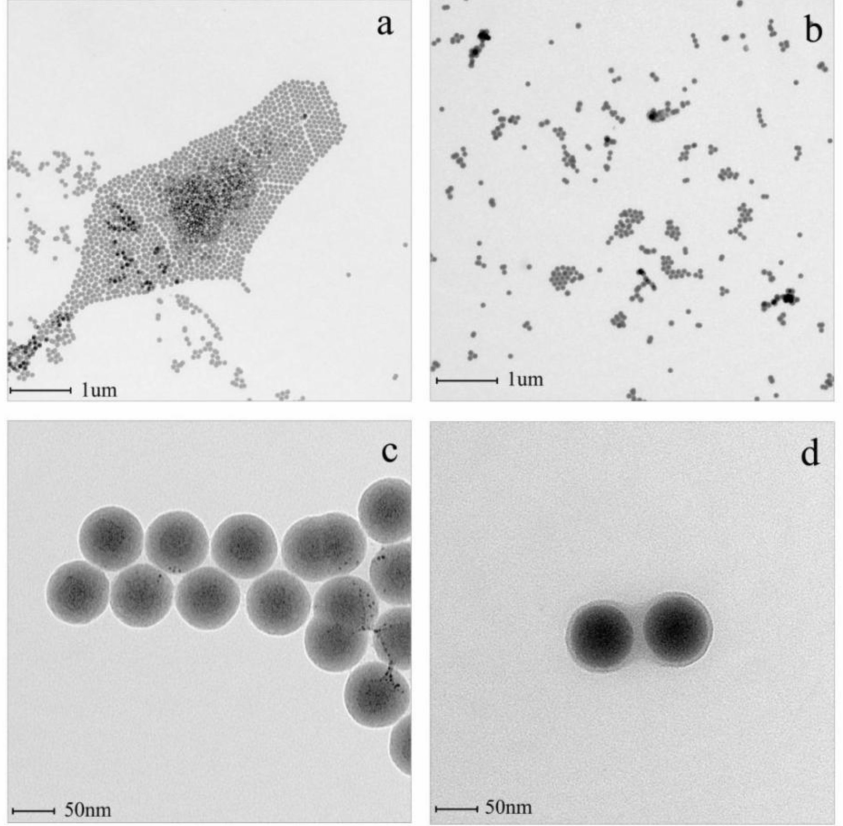
Figure 3. The TEM images of SiO 2 ( a , c ) and the SiO 2 - g -PHEMA ( b , d ) NPs. The surfactant fPEG contains hydrophilic segments (PEG) and low-surface-energy segments (CF x ), so it was often grafted onto the surface of the material for surface mod- ification [22–24]. In this study, fPEG is selected as the membrane-surface modifier. For comparison, mPEG (Mn = 1000), containing only hydrophilic segments, is also grafted onto the membrane surface. The influence of the chain size on the porosity of the membrane surface could be eliminated due to the molar mass of the two molecules that are close to one another. In order to effectively graft fPEG and mPEG molecules onto the surface of the PES/SiH1 composite membrane, mPEG-COOH and fPEG-COOH with carboxyl end group were firstly prepared by esterification reaction. Figure 4A depicts the spectra of fPEG and fPEG-COOH. Compared with fPEG, the new peaks at 2.65 ppm and 4.20 ppm are ascribed to -C(O)-CH 2 CH 2 -C(O)- and -CH 2 -OC=O-, respectively. Moreover, the intensity ratio of the peak b and peak a is about 2, confirming the successful preparation of